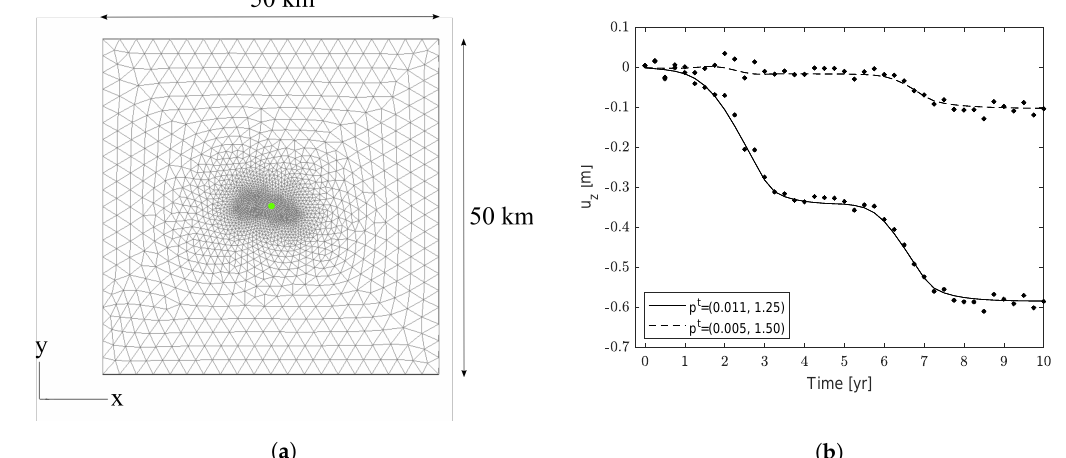
Figure 2. ( a ) 2D view of the model top with the green point indicating the location where the measurements are supposed to be recorded. ( b ) Synthetic sequence of vertical displacements u z used in the assimilation process for two different parameter sets p t . The continuous and dashed lines are the outcomes of the geomechanical model, while dots and squares indicate the assimilated